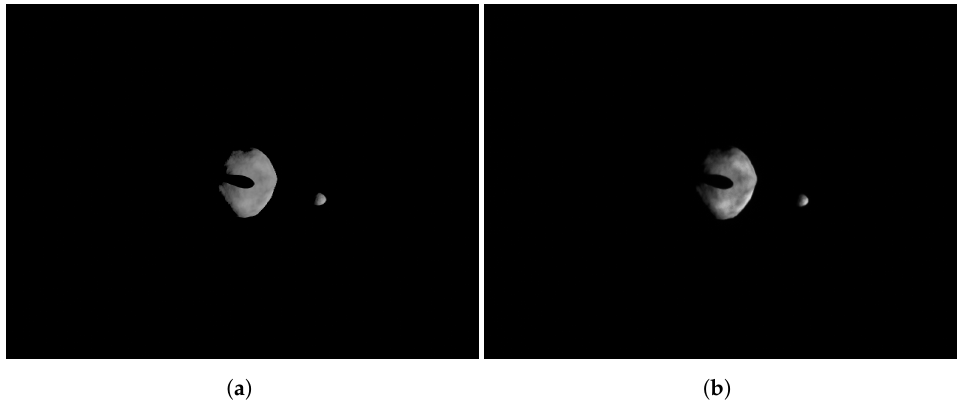
Figure 21. Example of image taken during the FRP. ( a ) Image taken by the camera in the virtual world. ( b ) Image taken by the camera in TinyV3RSE.